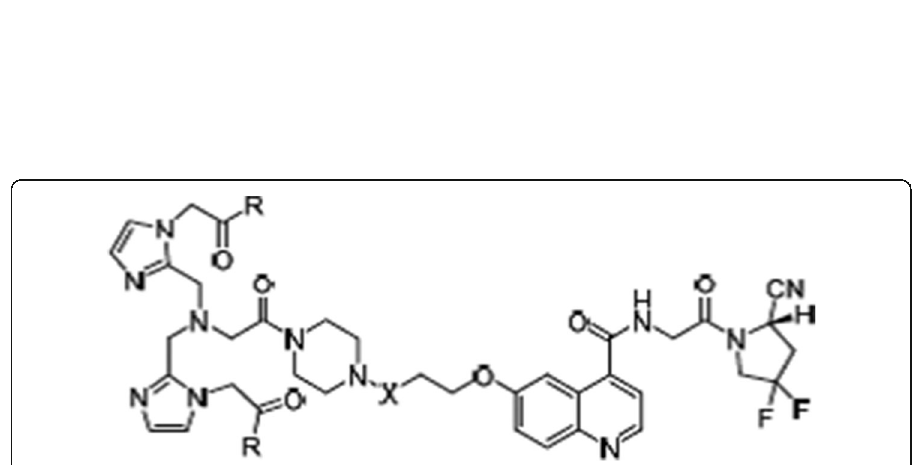
Fig. 4 Structure of quinolone-based FAPIs for labelling with Tc/Re. This figure was originally published in JNM. Authors: Lindner et al. J Nucl Med. 2020